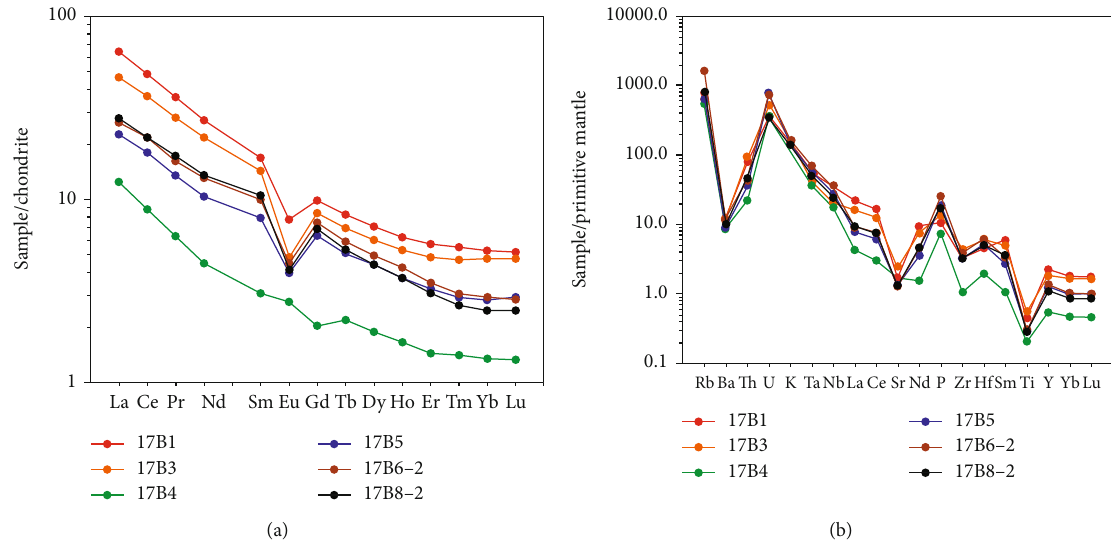
Figure 5: Chondrite-normalized REE distribution patterns (a) and primitive-mantle-normalized trace element distribution patterns (b) of the Bieyesamas monzogranite (after